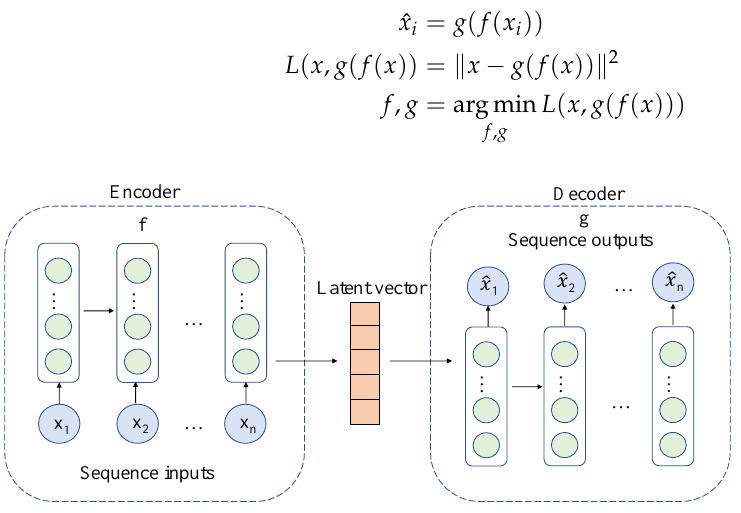
Figure 5. Graph of the encoder-decoder